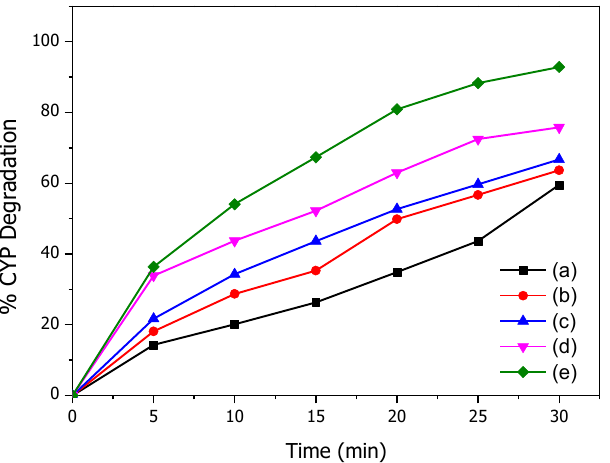
Figure 3. Effect of catalyst dosage on degradation of CYP: (a) 0, (b) 10, (c) 25, (d) 50, and (e) 100 mg Mg(OH) 2 .